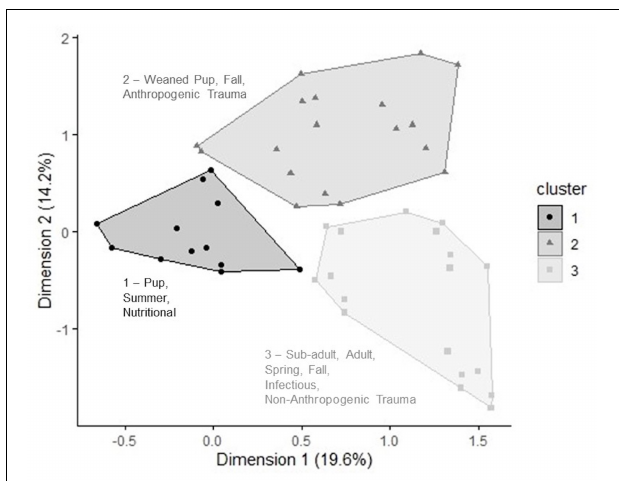
FIGURE 6 | Hierarchical clustering performed on the resulting principal components of a multiple correspondence analysis. Clusters 1–3 represent groups of harbor seals sharing high frequency for categories within the variables: age class, cause of death, and season of stranding. Inertia values for each dimension are labeled on